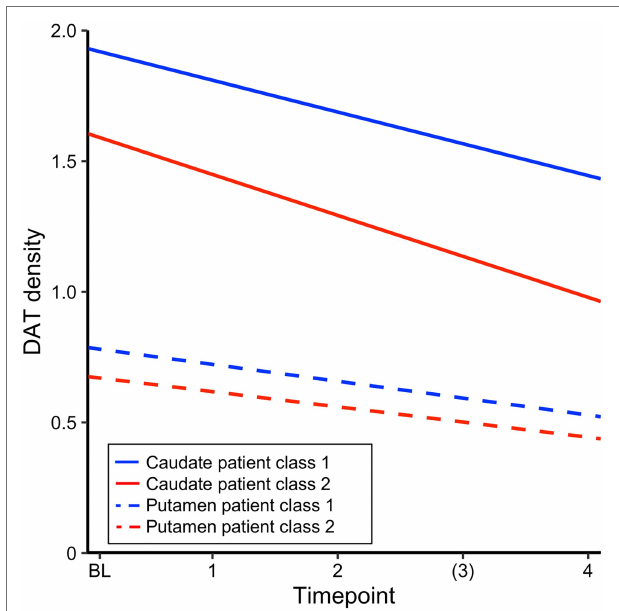
FIGURE 2 | Estimated intercept and slopes of dopamine transporter (DAT) density for each patient class from a linear mixed effects model with time and class, run separately for caudate and putamen.